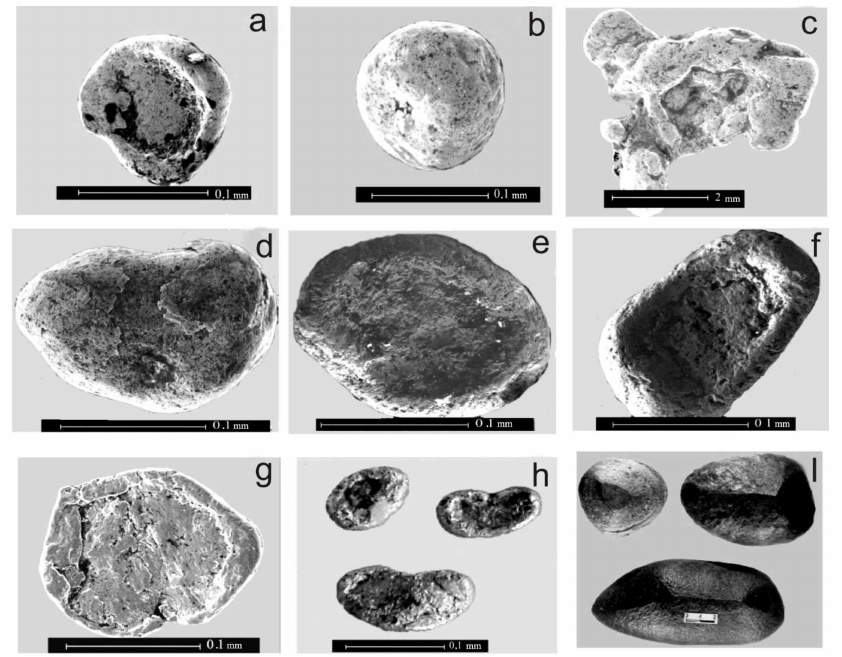
Figure 17. Gold with signs of wind-worn processing and ventifacts from the Quaternary deposits of the East of the Siberian Platform: ( a – c ) Lena–Anabar interfluve; ( d – f ) Lena–Viluy interfluve; ( g , h ) basin of the middle course of the Lena River; ( i )